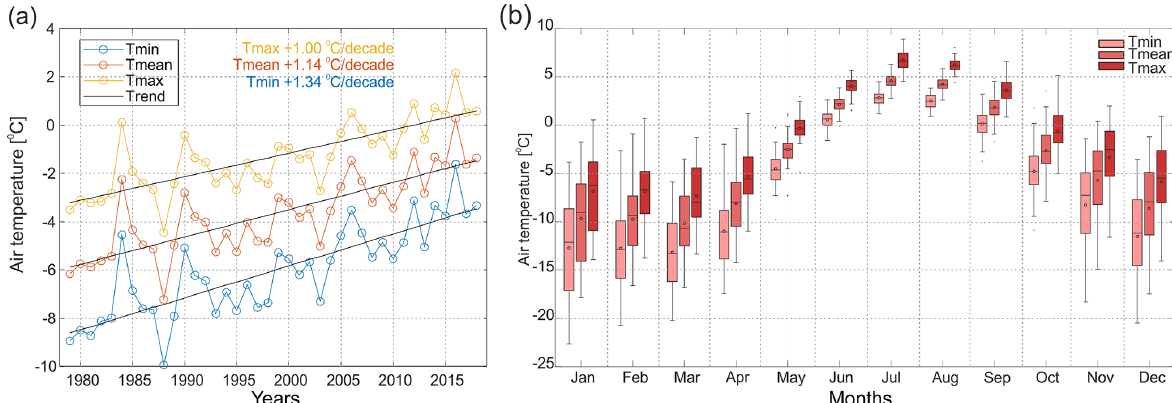
Figure 2. (a) Variability of an annual mean of min, mean, and max air temperatures in 1979–2018. (b) Variability of the monthly mean of min, mean, and max air temperatures in 1979–2018. On each box, the central line indicates the median, the circle represents the mean, and the bottom and top edges of the box indicate the 25th and 75th percentiles, respectively. The whiskers that extend to the most extreme data points are not considered outliers, and the outliers are plotted individually as